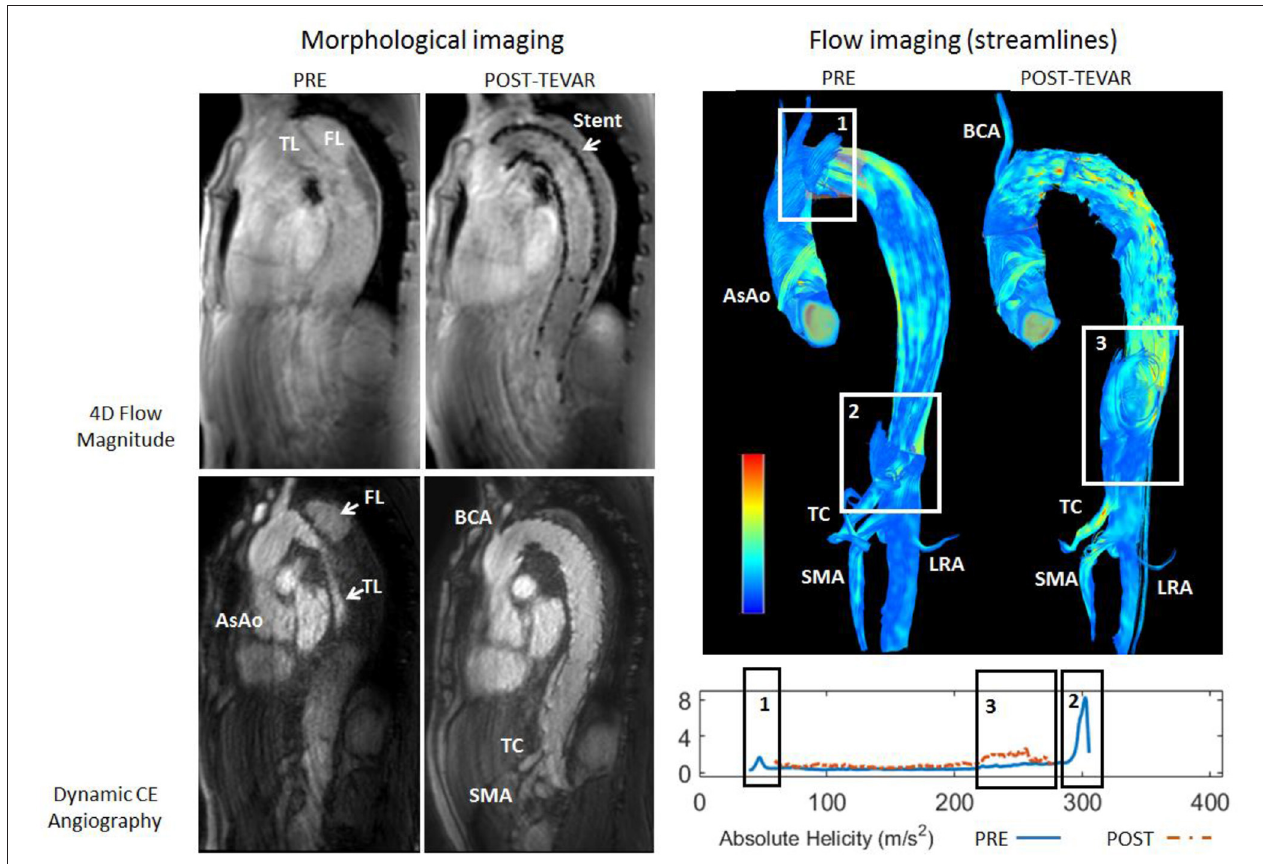
FIGURE 1 | Top: Streamline visualization of the pre-operative and post-operative flow patterns in the aorta of Patient 4. Pre-operatively, presence of helical flow can be observed in the false lumen resulting from the primary entry tear (rectangle 1) and at the ostium of the truncus caeliacus (TC, rectangle 2). Post-operatively, presence of helical flow can be observed in the false lumen downstream of the endo-prosthesis at the diaphragmatic level (rectangle 3). Bottom: Plots of absolute helicity along the false lumen, in agreement with the qualitative